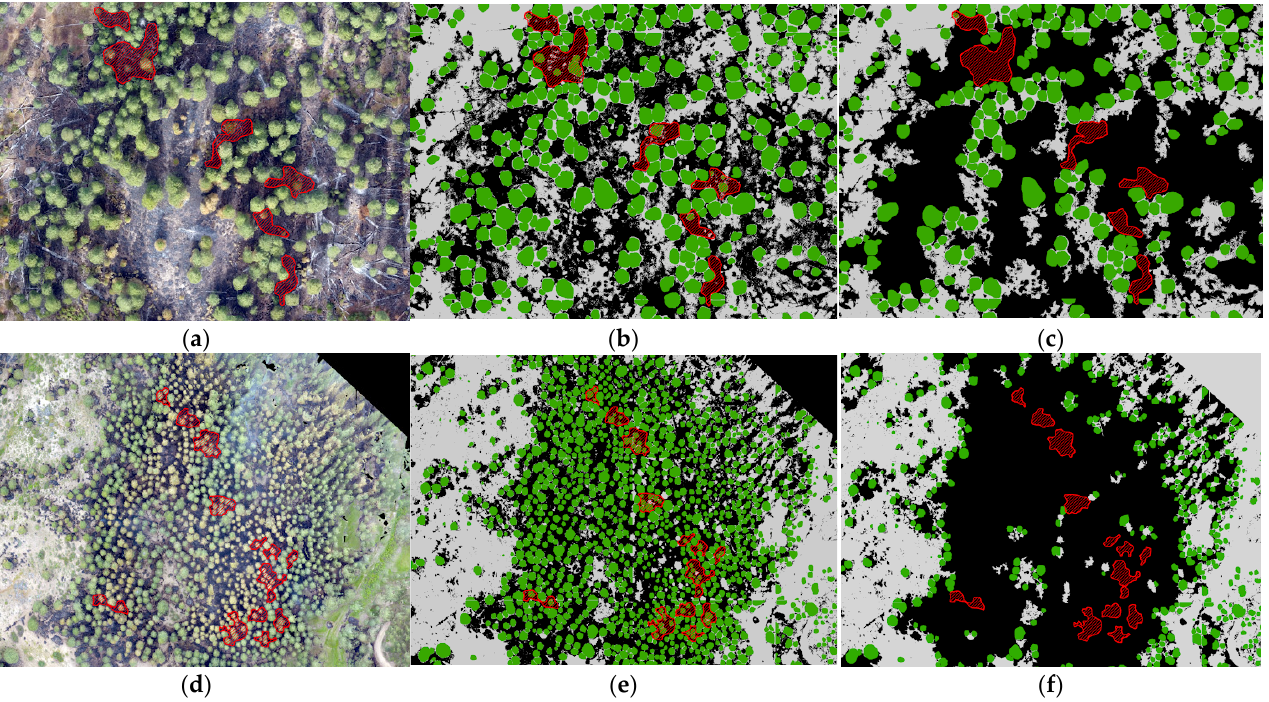
Figure 9 . ( a ) Cottonwood fire orthomosaic with validation data overlaid on top. The polygons in red encompass part of the burn extent. ( b ) Cottonwood fire combined raster outputs displaying the canopy pixels and burn pixels. ( c ) Final Cottonwood fire raster outputs after having reclassified sub-crown burn and unburned tree noise. ( d ) Hoodoo fire orthomosaic with validation data. ( e ) Hoodoo fire combined raster outputs and validation data ( f ) Hoodoo fire Sub-Crown Burn Reclassification output with validation data polygons.